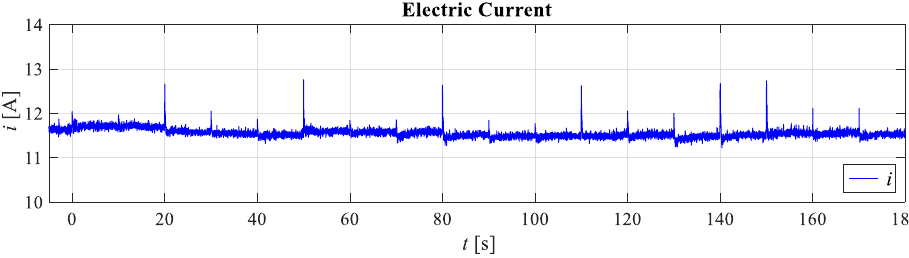
Figure 18. Experimental results of flat quadrotor configuration (FX4) energy consumption.